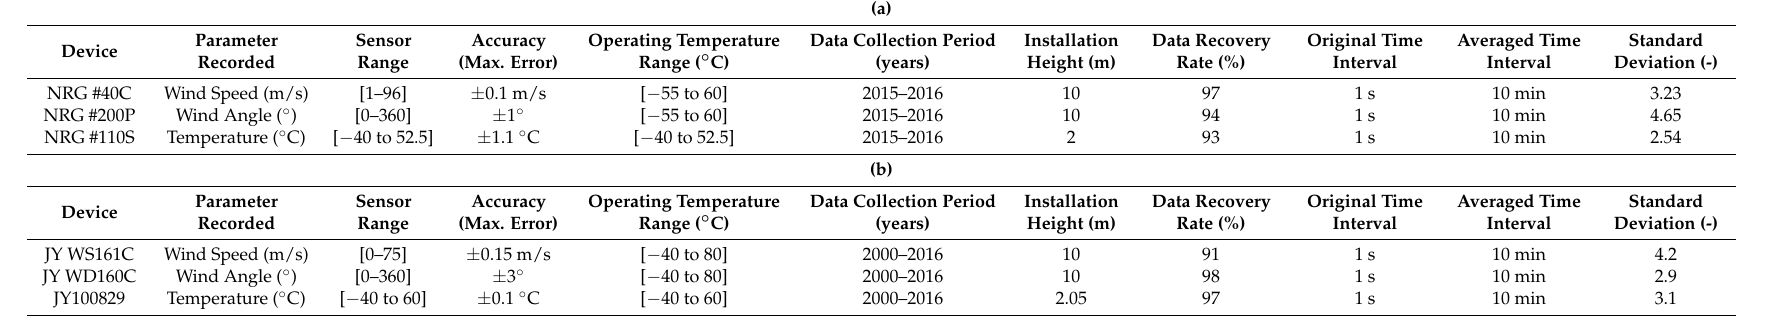
Table 1. ( a ) Wind data acquisition specifications at test site; ( b ) Wind data acquisition specifications at reference site